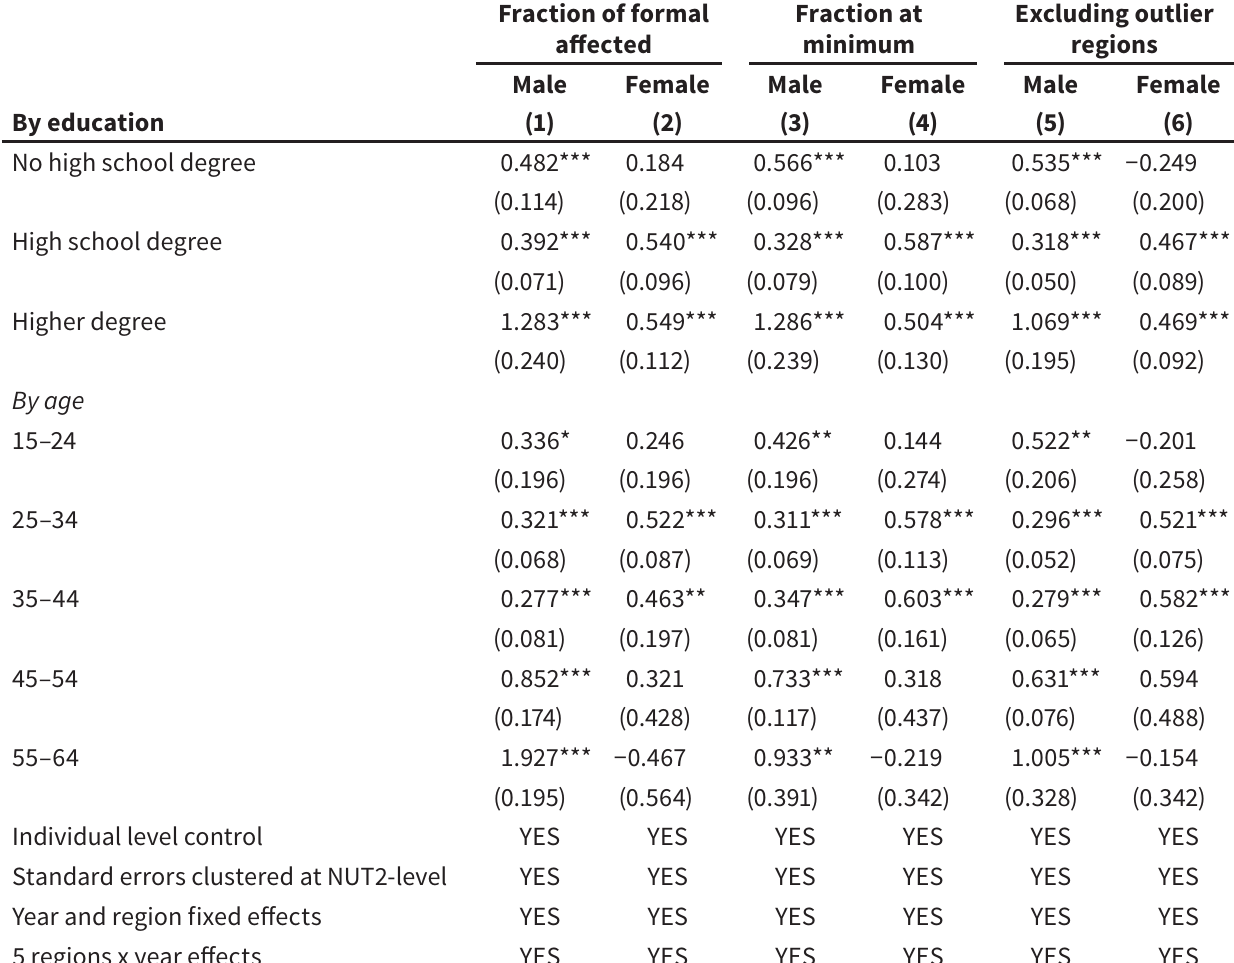
Wage effects, alternative estimation using the alternative exposure variables or excluding